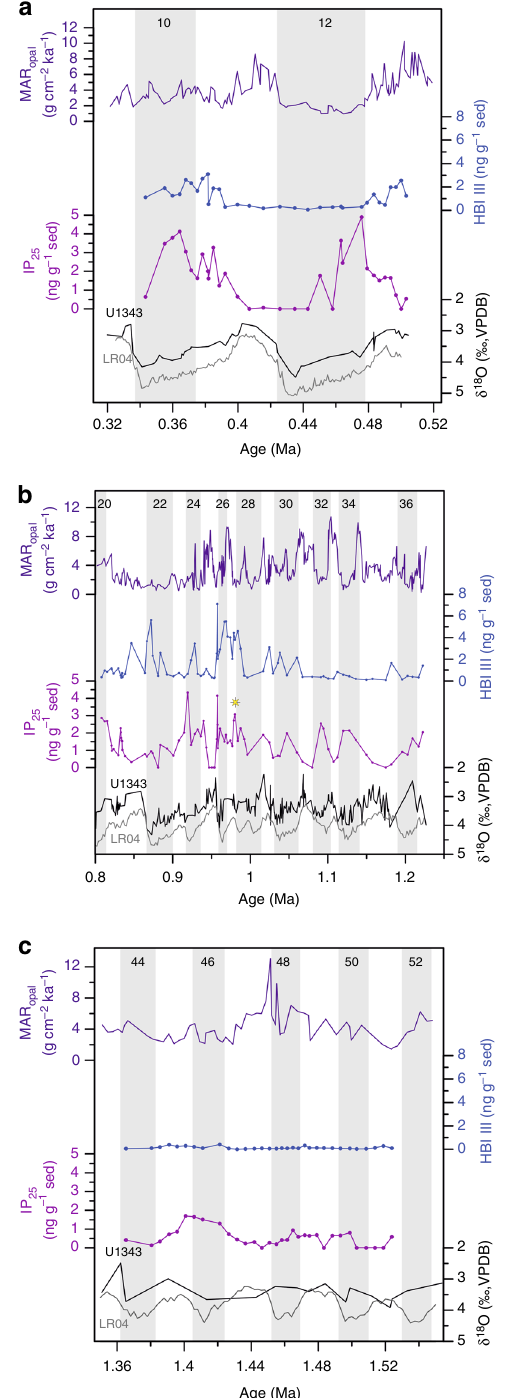
Fig. 2 Bering Sea biomarker patterns across the three studied Pleistocene intervals. Overview of the three time intervals analysed for biomarkers. a 0.34 − 0.5 Ma, b 0.8 − 1.22 Ma and c ~1.36 – 1.53 Ma. Sedimentary mass accumulation rate of biogenic opal (MAR opal ) in Site U1343 is in purple 36 . IP 25 (violet) and HBI III (blue) in Site U1343 are expressed in ng g − 1 dry sediment (sed). The benthic foraminiferal oxygen isotope record of Site U1343 42 is in black together with the LR04 stack 16 in grey. The light grey vertical bars indicate glacial intervals and the white bars characterise interglacials (numbers at the top correspond to MISs, MIS boundaries from Lisiecki and Raymo 16 ). The yellow asterisk indicates the fi rst glacial interval where a late-glacial/deglacial sea ice maximum is observed (MIS